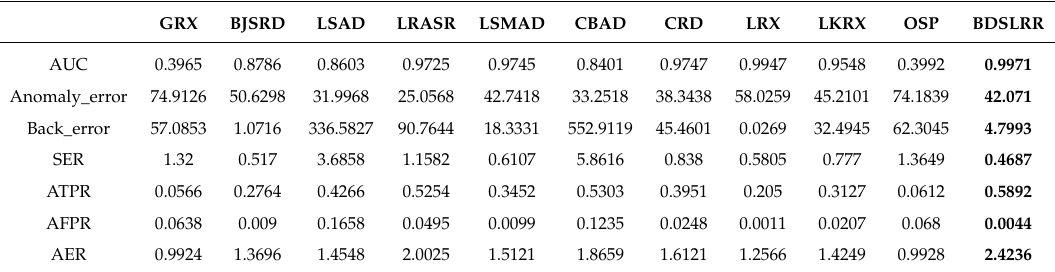
Table 1. Synthetic Dataset: Assessment Metric